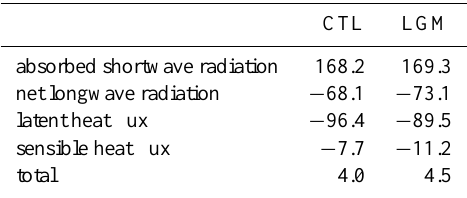
Table 2. Annual mean basin average heat fluxes for the Mediter- ranean in W/m 2